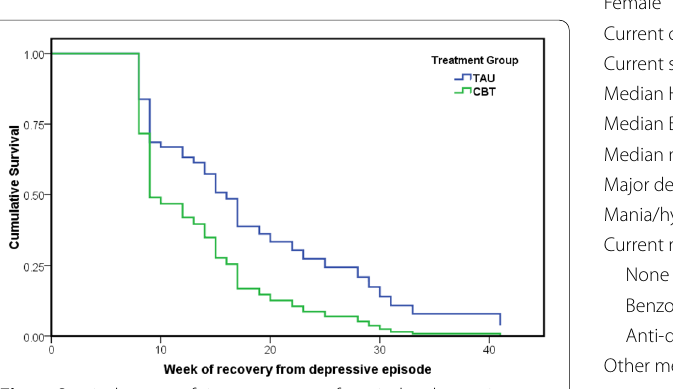
Fig. 1 Survival curves of time to recovery from index depressive episode according to group (Cox regression analysis; see text for co-variates)